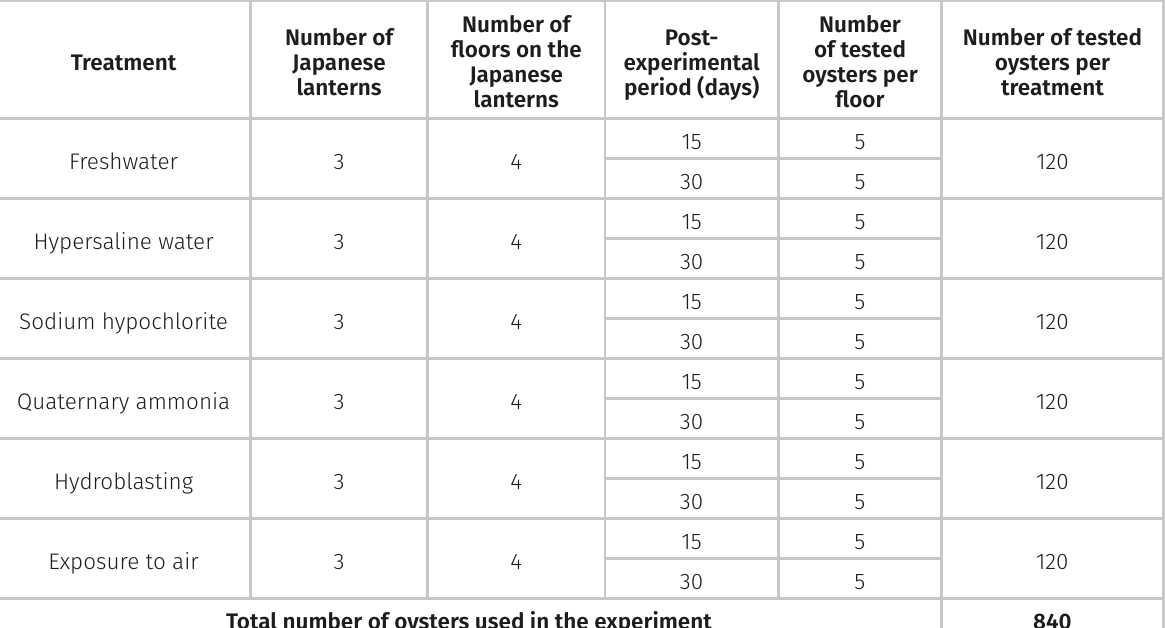
Table II. Experimental design adopted to the evaluation of different methodologies for the reduction of epibionts on the mangrove oyster ( Crassostrea gasar ) during cultivation